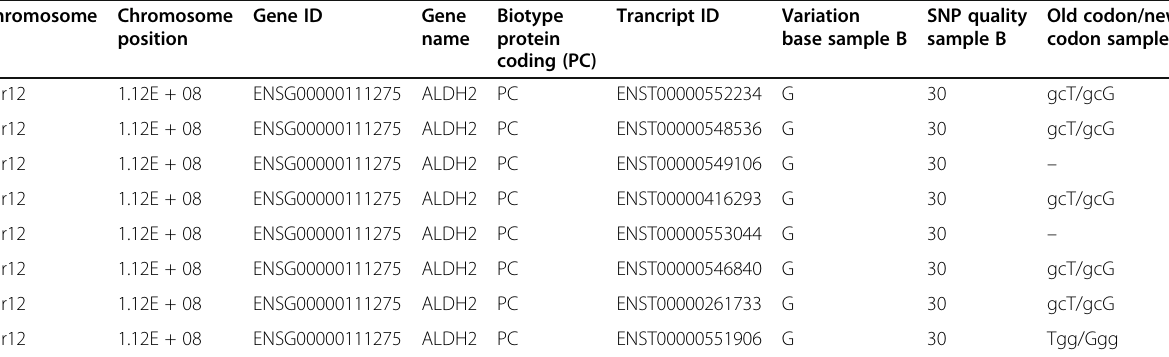
Table 4 Single-nucleotide polymorphism (SNP) with codon mutation from T to G in ALDH2 gene in breast cancer samples Chromosome Chromosome